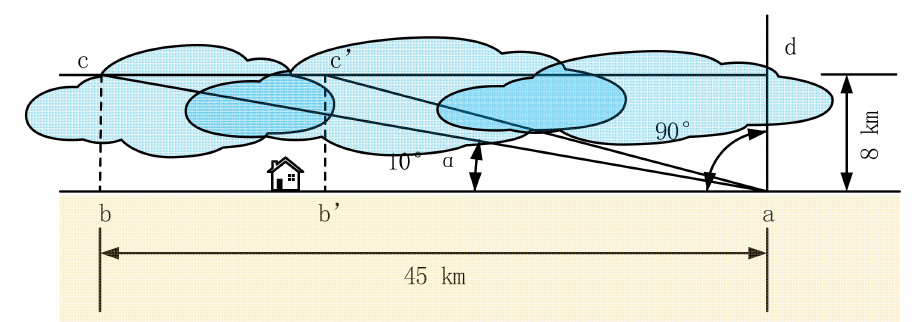
Figure 2. Ground projection distance ( a – b ) of the segment ( a – c ) between the receiver ( a ) and point ( c ). The point ( c ) is the intersection of the ray and